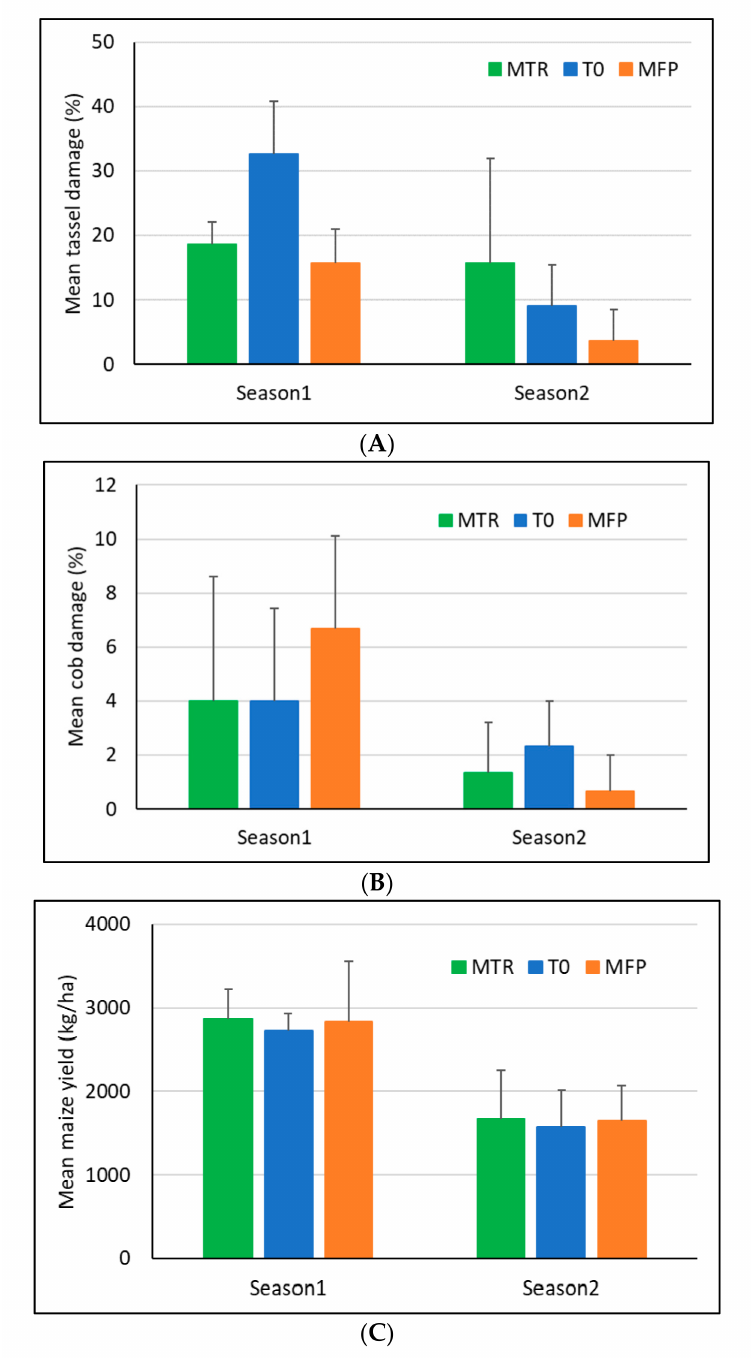
Figure 8. Mean (+SD) tassel damage ( A ), cob damage ( B ) and maize grain yield ( C ) during the two maize growing seasons in Ghana in 2020. MTR = T. remus release plots; T0 = plots without T. remus releases, no pest control; MFP = farmers’ conventional practice including chemical pest control; 4 replicates per treatment and